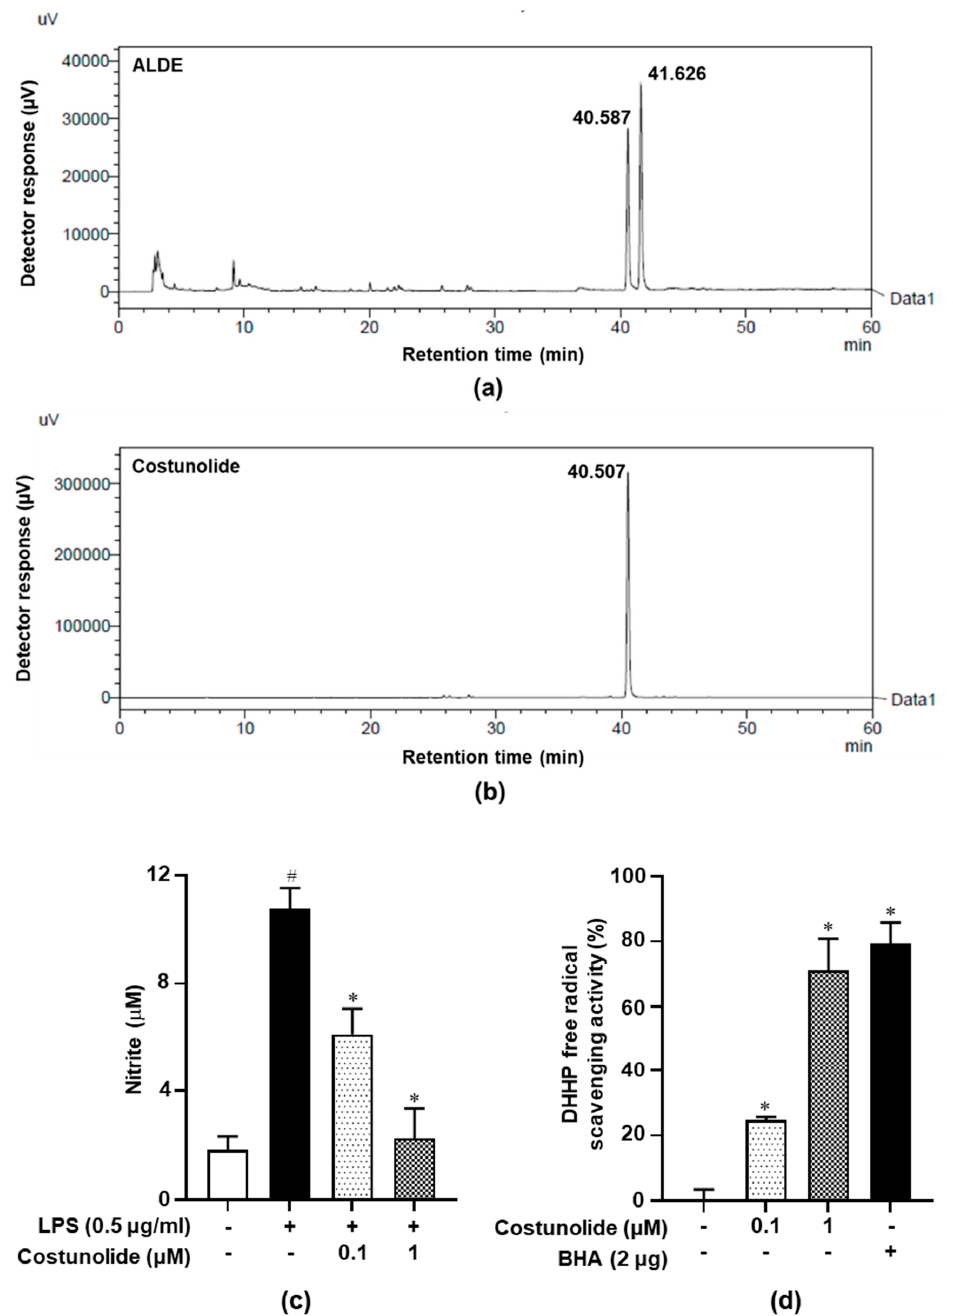
Figure 1. HPLC analysis of the ethanol extract of Aucklandia lappa Decne. (ALDE) and costunolide. The phytochemical characteristics of ( a ) ALDE and its major component, ( b ) costunolide, were analyzed using HPLC. ( c , d ) NO inhibitory effect of costunolide. Data represent the mean ± SEM of three independent experiments. # p < 0.05 vs. LPS-untreated control group; ∗ p < 0.05 vs. LPS-treated